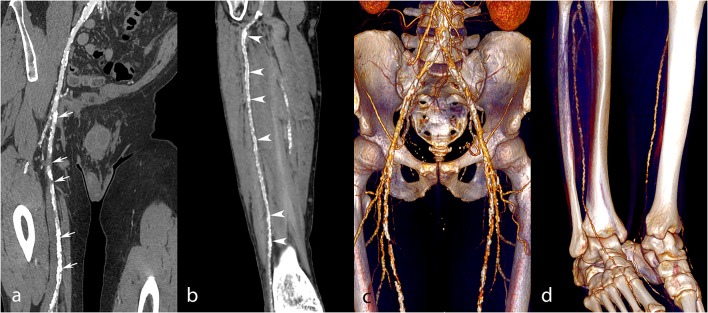
Lower extremity CT angiography obtained with the SA technique in a 54-year-old man with a history of insulin-requiring type 2 diabetes, hypertension, past stroke, and myocardial infarction, who was admitted due to Fontaine stage III peripheral arterial disease. Curvilinear reconstructions (a,b) and corresponding volume rendering reconstructions (c,d) of the right iliofemoral arterial system and anterior tibial artery. Several severe stenoses and occlusions were found along the superficial femoral artery (a,c, white arrows). At the tibial and pedal levels (b,d), the arterial enhancement is non-optimal but sufficient for a diagnosis. Nevertheless, note the extensive arterial wall calcifications of the anterior tibial artery (white arrowheads) related to diabetes, rendering the analysis difficult. Attenuation measurements were as follows: aortic level, 261 HU; iliac level, 271 HU (right), and 256 HU (left); femoral level, 191 HU (right), and 176 HU (left); tibial level 187 HU (right), and 172 HU (left); pedal level, 112 HU (right), and 107 (left). HU, Hounsfield units.